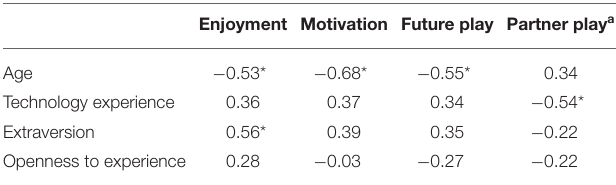
TABLE 2 | Correlations between demographic variables and exergame